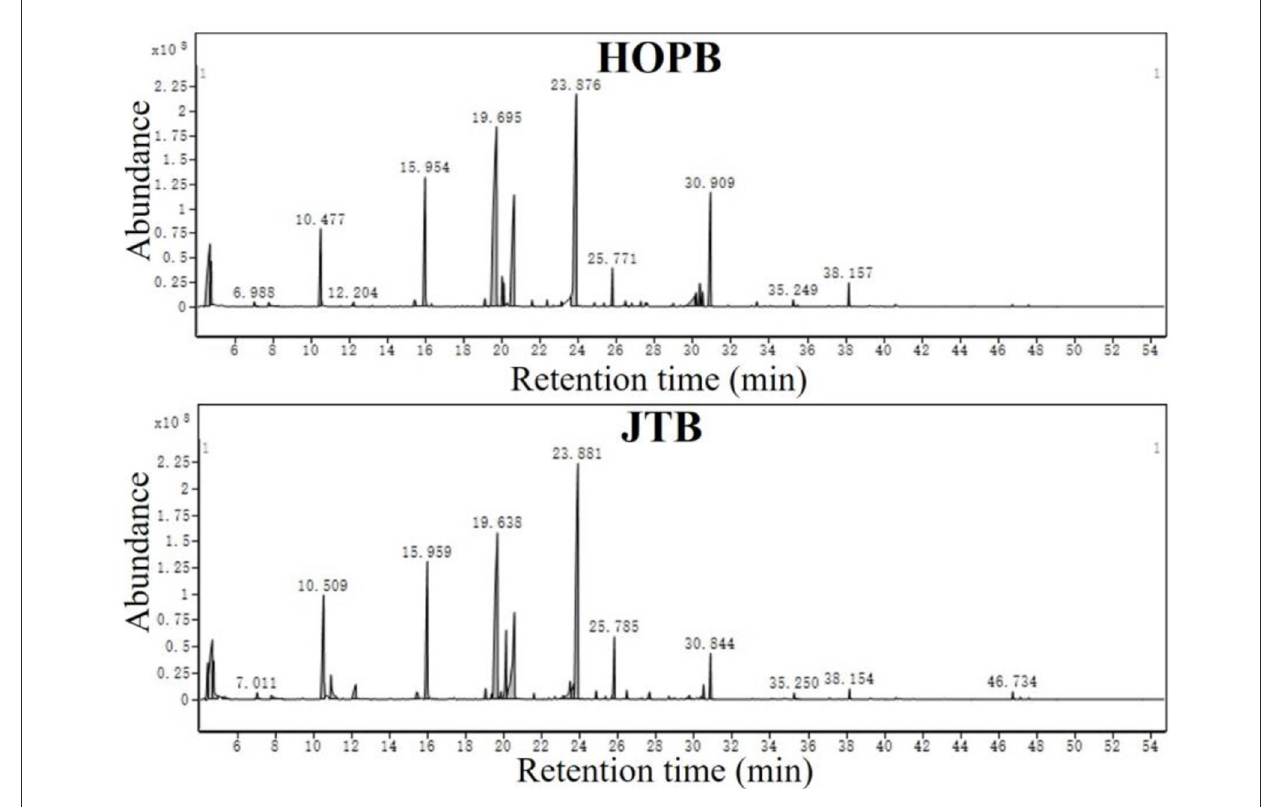
FIGURE2 Total ion current (TIC) chromatograms of beer